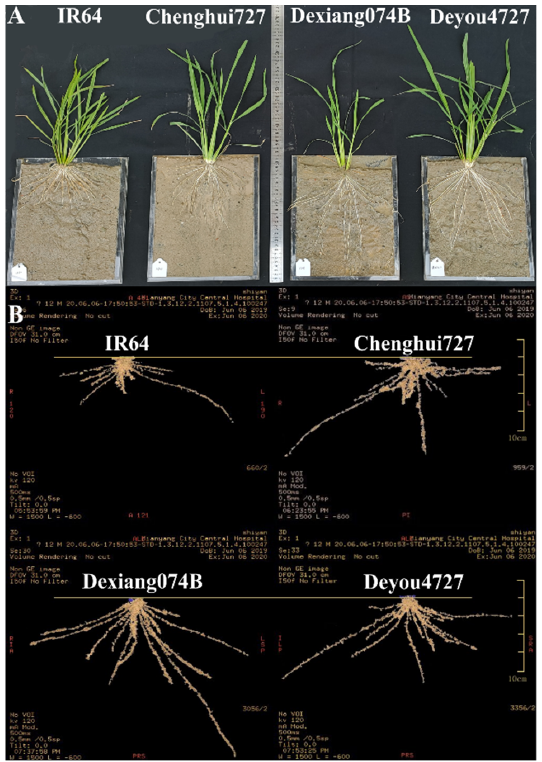
Figure 3. The root morphology of IR64, Deyou4727, and its parents in two dimensions ( A ) and three dimensions ( B ).